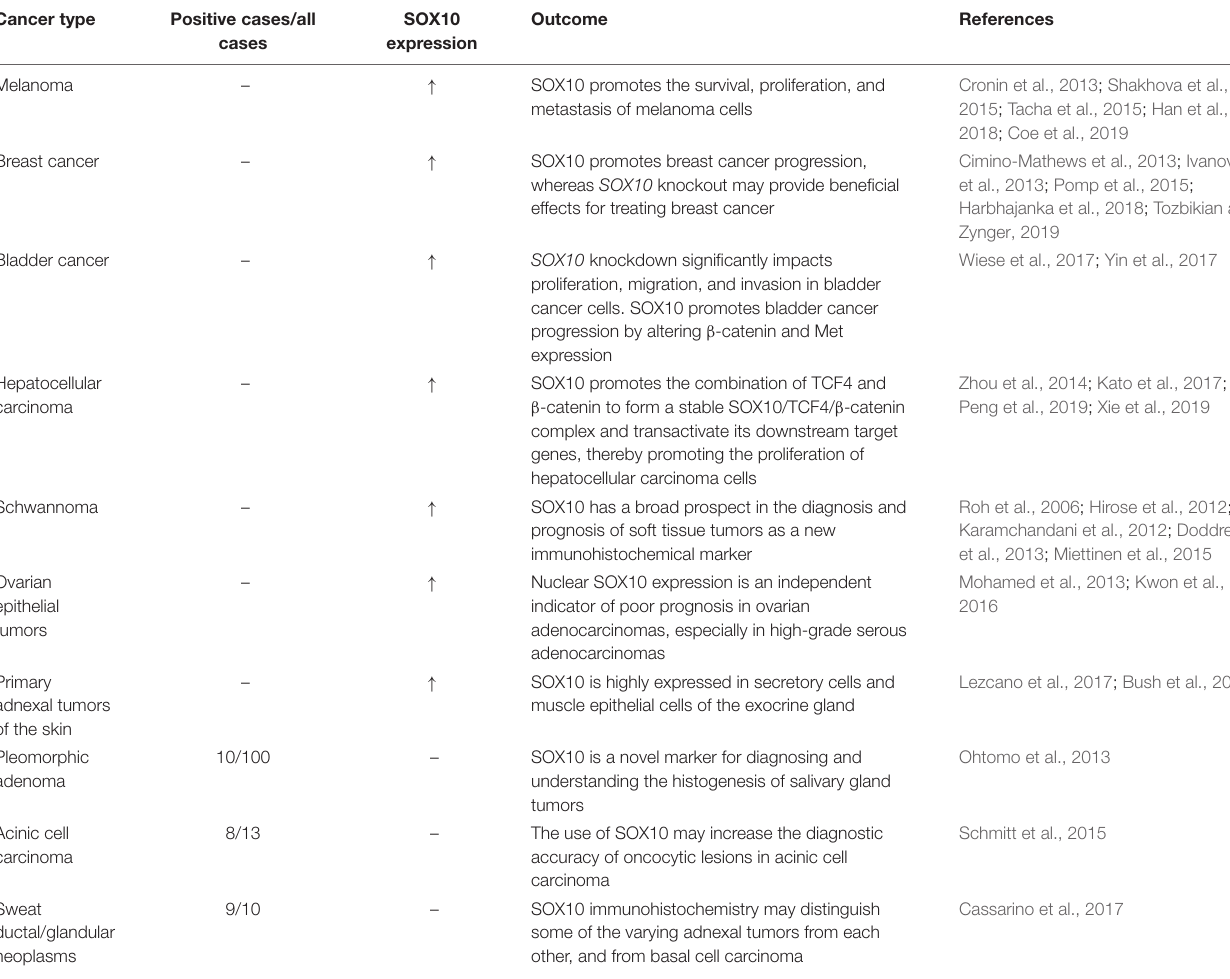
TABLE 2 | Roles of SOX10 expression in different